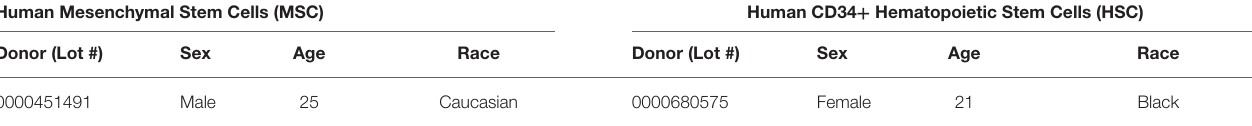
TABLE 3 | Stem cell donor information for the bone marrow MPS. Human Mesenchymal Stem Cells (MSC) Human CD34 + Hematopoietic Stem Cells